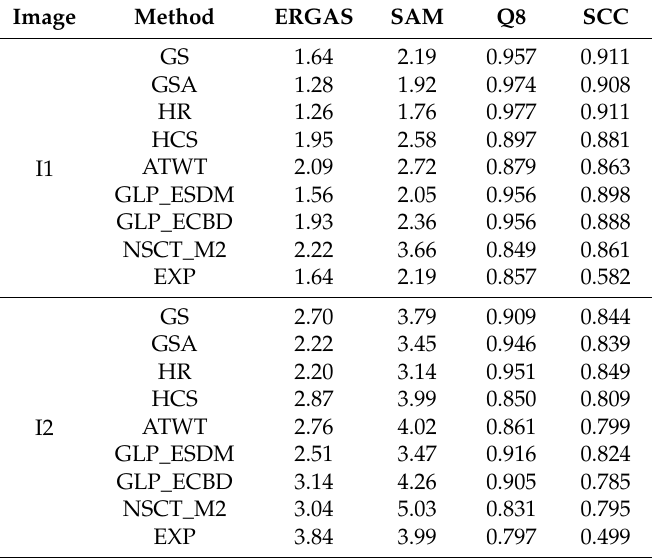
Table 2. Quality indices of the fused images generated by the selected algorithms for the two urban